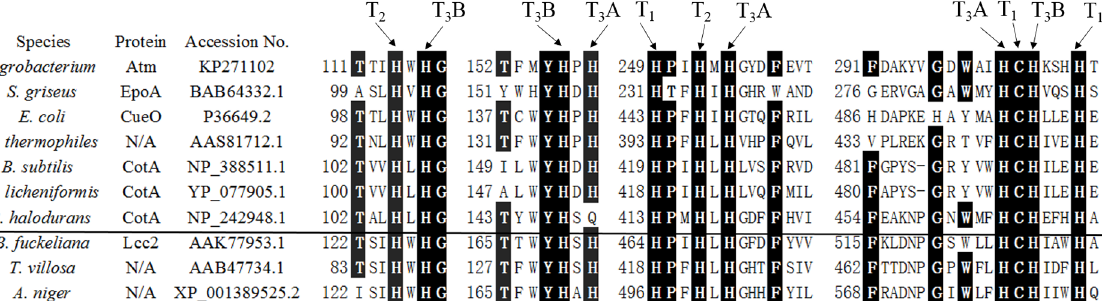
Fig 2. Alignment of the four copper-binding sites in laccases-related proteins. Conserved amino acids are highlight in black. T 1 , T 2 , T 3 A, and T 3 B indicate the putative corresponding type 1, 2, and 3 copper centers. For each copper center, arrows point to the copper-binding amino acid residues. The horizontal line separates bacterial proteins (above the line) from fungal proteins (below the line). S . griseus : Streptomyces griseus ; E . coli : Escherichia coli K- 12; T . thermophilus : Thermus thermophilus HB27; B . subtilis : Bacillus subtilis ; B . licheniformis : Bacillus licheniformis ; B . halodurans : Bacillus halodurans C- 125; B . fuckeliana : Botryotinia fuckeliana ; T . villosa : Trametes villosa ; A . niger : Aspergillus niger .